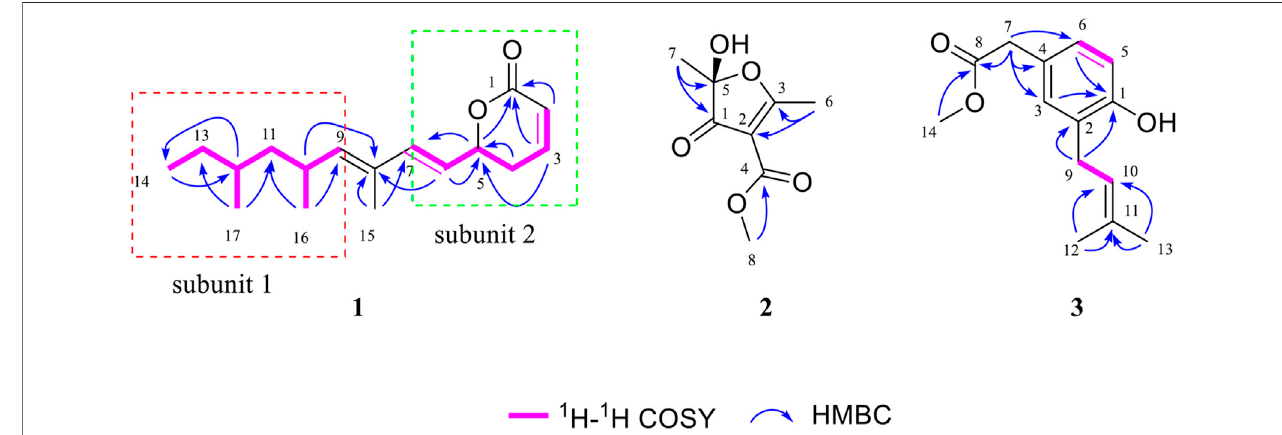
FIGURE 2 | Selected 1 H – 1 H COSY and HMBC correlations of 1 – 3 .